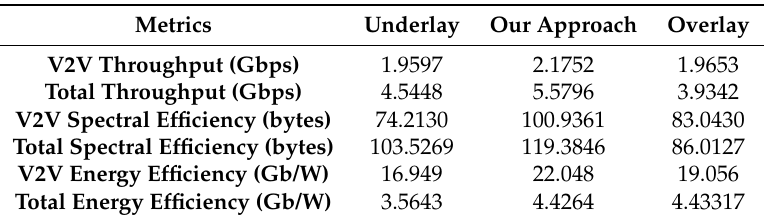
Table 9. Summary of Average Simulation